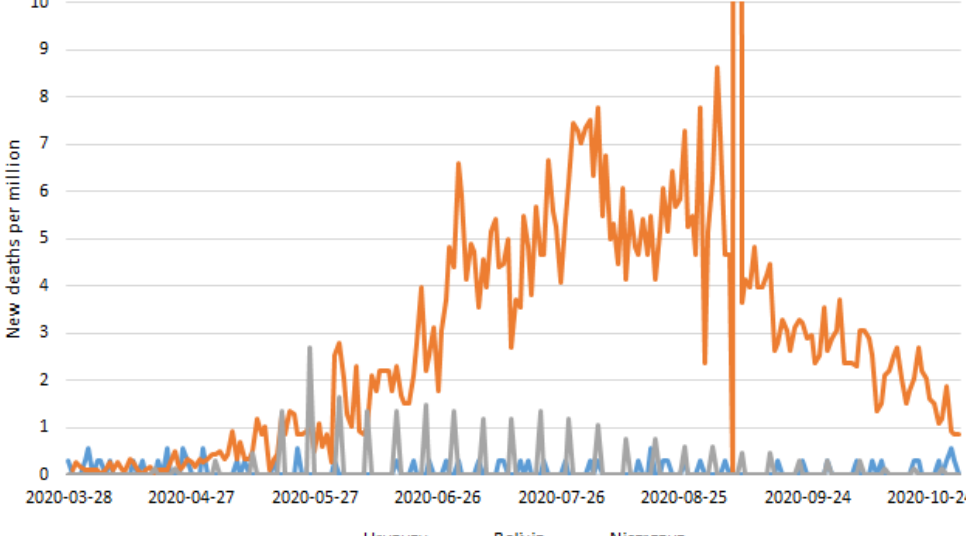
Table A3. Exploratory factor analysis, mean, standard deviation, average variance extracted, and composite reliability.